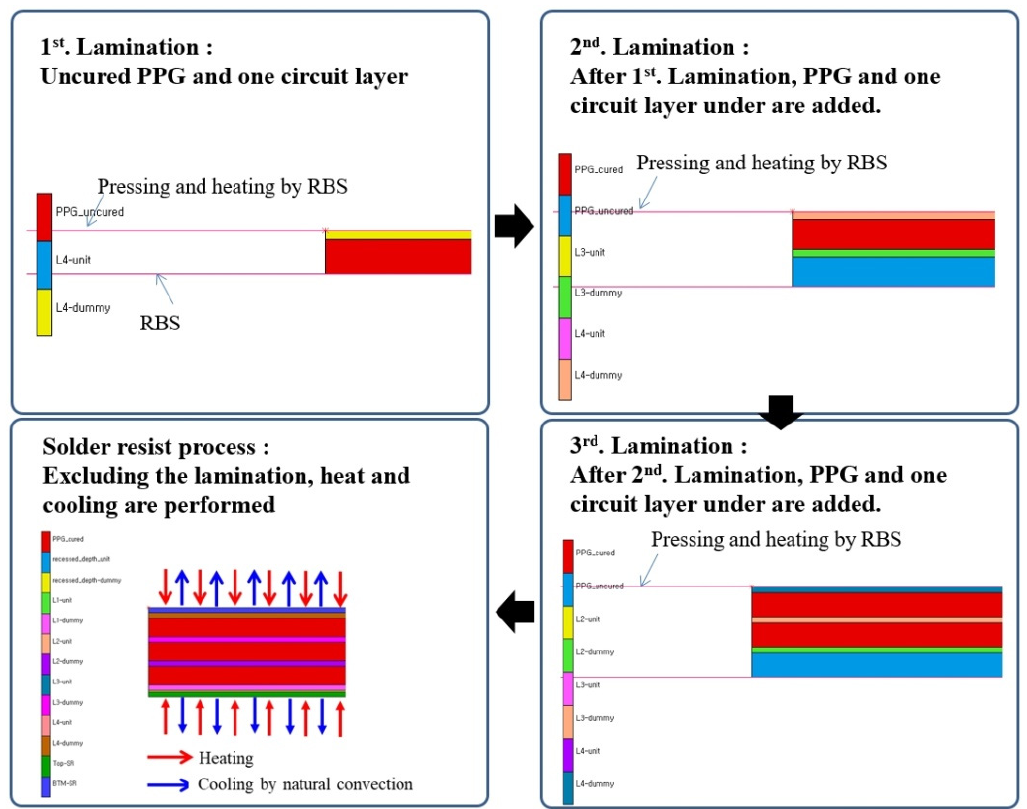
Figure 15. Boundary conditions of the laminating process.